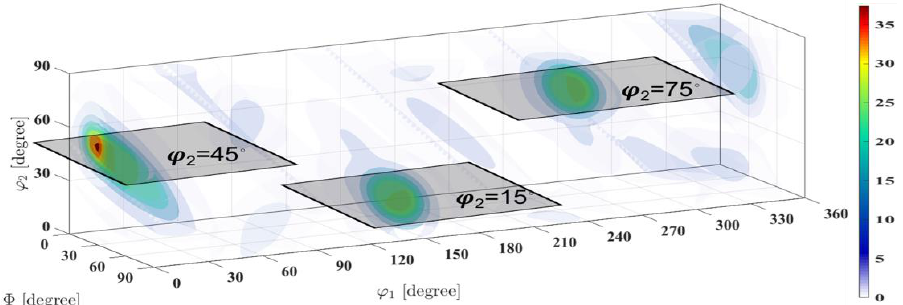
Figure 7. Three-dimensional (3D) void orientation distribution function (ODF) (3D-VODF). Three 𝜑 2 sections ( 𝜑 2 = 15°, 45°, and 75°) consist of the dominant components with regard to voids orientations.